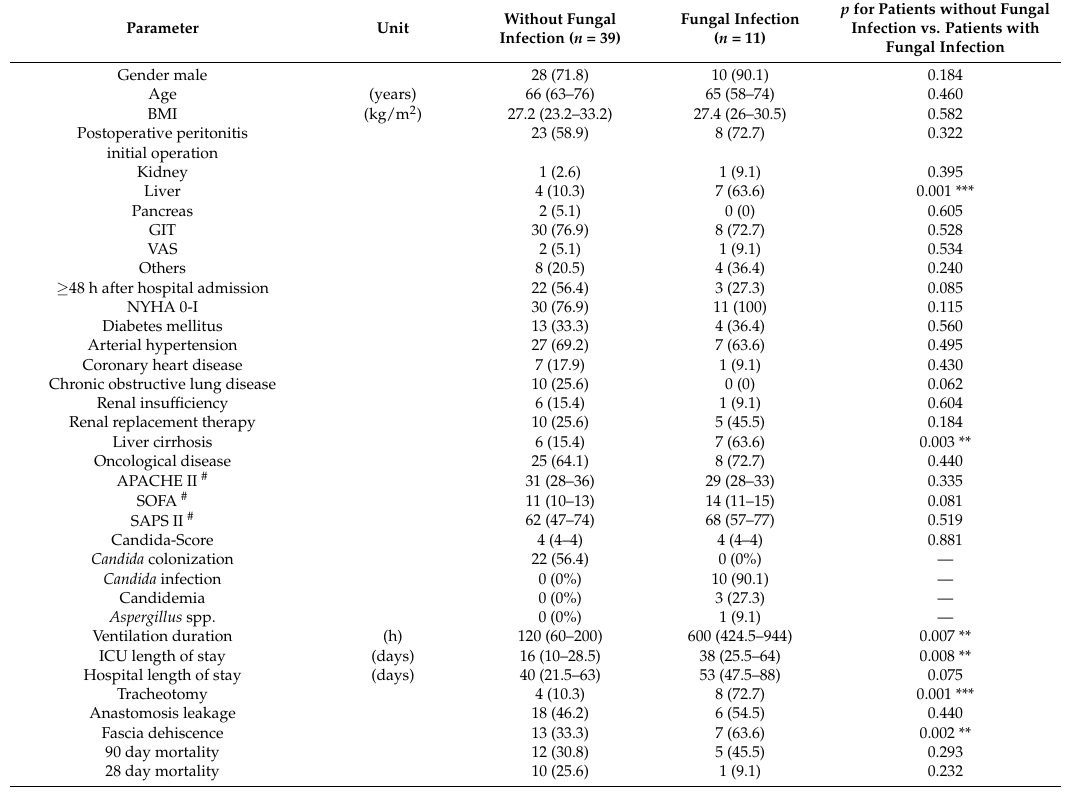
Data are presented either as number (with the corresponding percentage value) or as median (with accompanying quartiles (Q1–Q3). Legend: BMI = Body mass index, GIT = gastro intestinal tract, VAS = vascular artery surgery, NYHA = New York Heart Association score, APACHE II = Acute Physiology Health Evaluation score, SAPS II = Simplified Acute Physiology Score, SOFA = Sequential Organ Failure Assessment score; # calculated at sepsis onset. Concerning symbolism and higher orders of significance: ** p < 0.01, *** p < 0.001, — : not